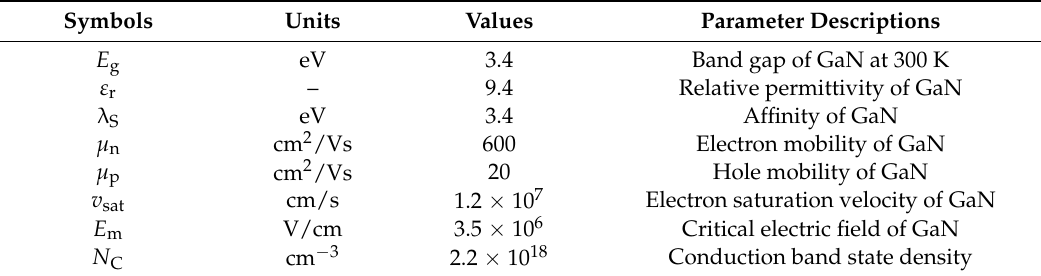
Table 2. Physical parameters adopted in the simulations after